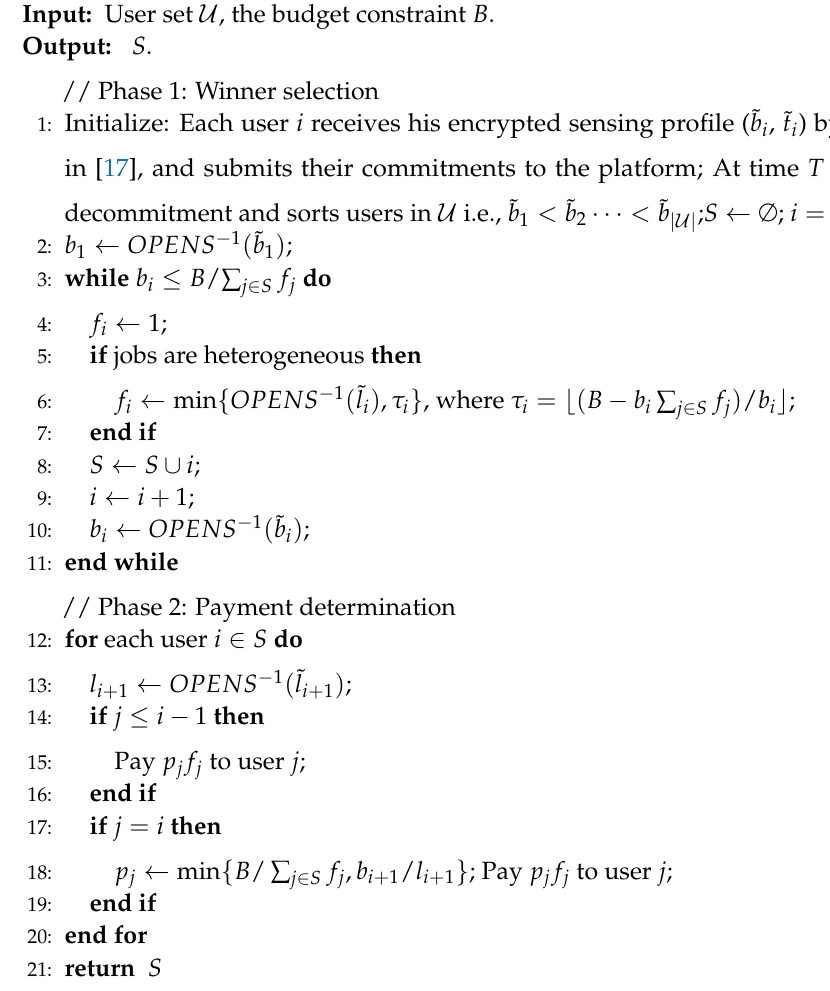
Algorithm 4 PVI-H // Privacy-Protection Verifiable Incentive Mechanism for Crowdsensing Applications with Homogeneous Sensing Jobs or Heterogeneous Sensing